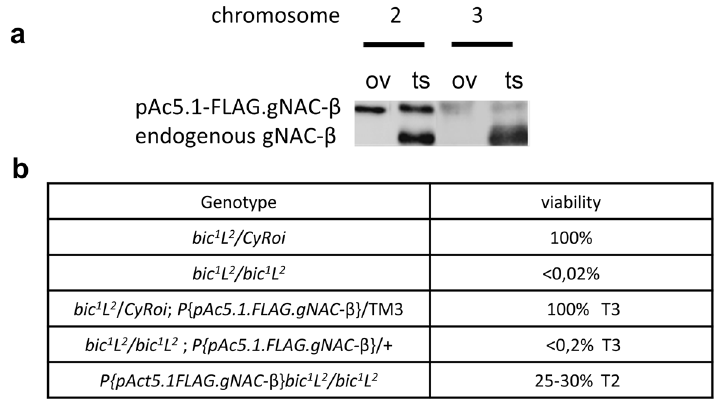
Figure 5. The lethal phenotype of the bic1 mutation caused by the loss of the ubiquitously expressed NAC-β is rescued by ectopic gNAC-β expression. ( a ) Western blot expression analysis of FLAGgNAC-β transgenes (T2 and T3) inserted into chromosome 2 or 3, respectively. ( b ) Relative viability of the genotypes demonstrating transgene T2-induced suppression effect. Full blot for ( a ) in Expanded file 4 in Supplementary.